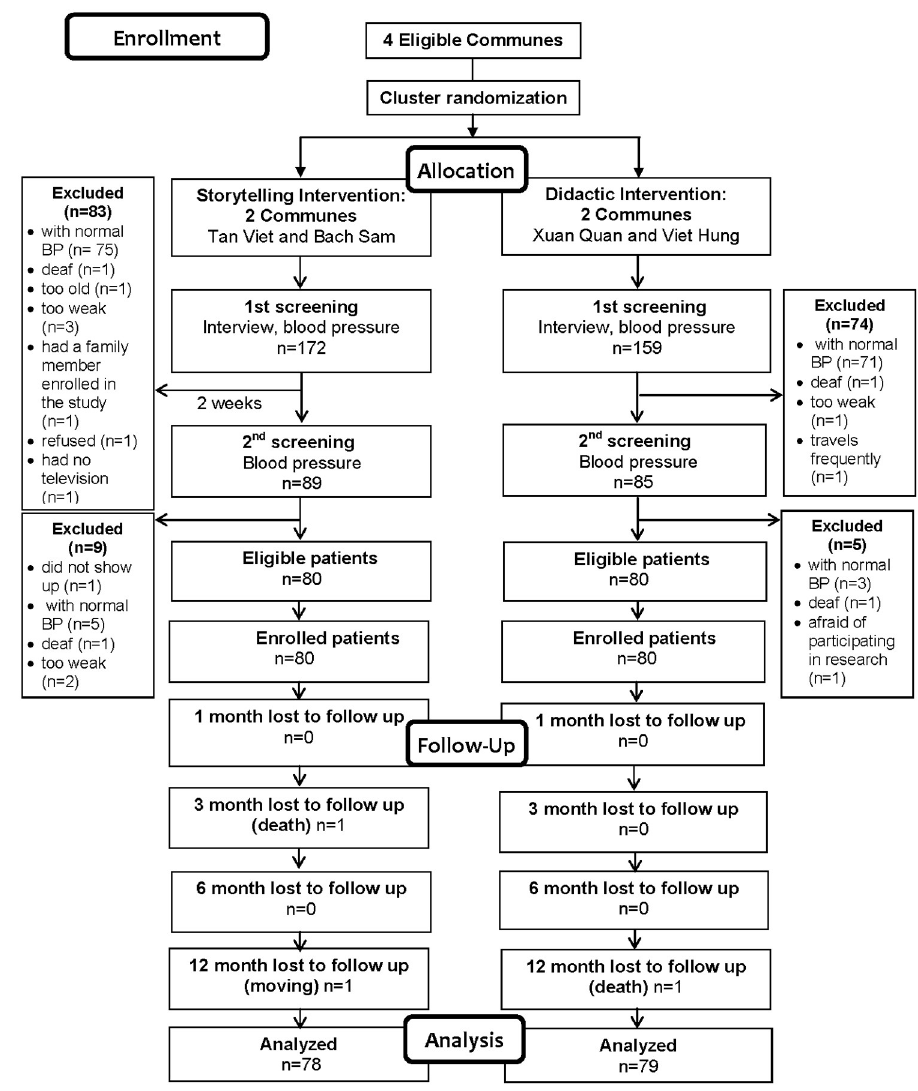
Fig 1. CONSORT flow diagram for the feasibility cluster randomized controlled